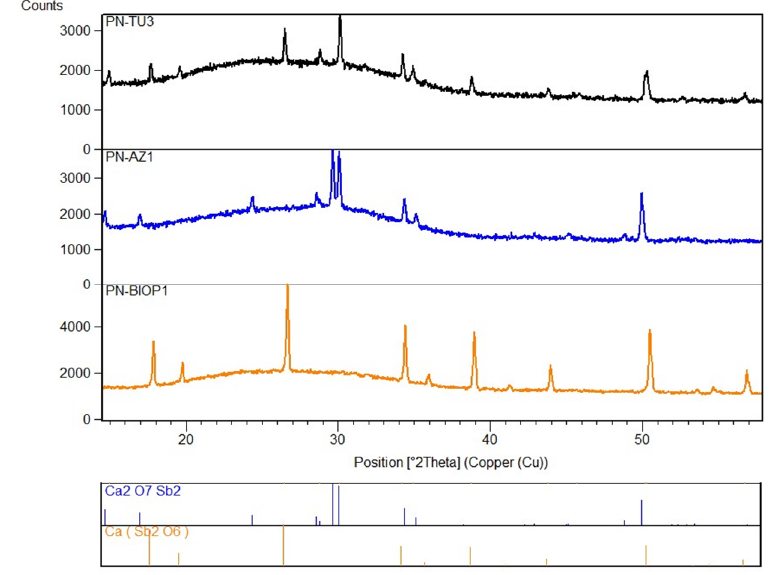
Figure 4. XRPD patterns of tesserae opacified by Ca-antimonates; note the association of the rhombic (Ca 2 Sb 2 O 7 ) and hexagonal phases (CaSb 2 O 6 ) in PN-TU3 (similar pattern in PN CE1, PN BO1, PN GR1, and TN VCH1), and the presence of the only rhombic phase in PN-AZ1, and of the only hexagonal one in PN-BIOP1 (similar pattern in PN TU1, TN TU1 and TN AZ2).